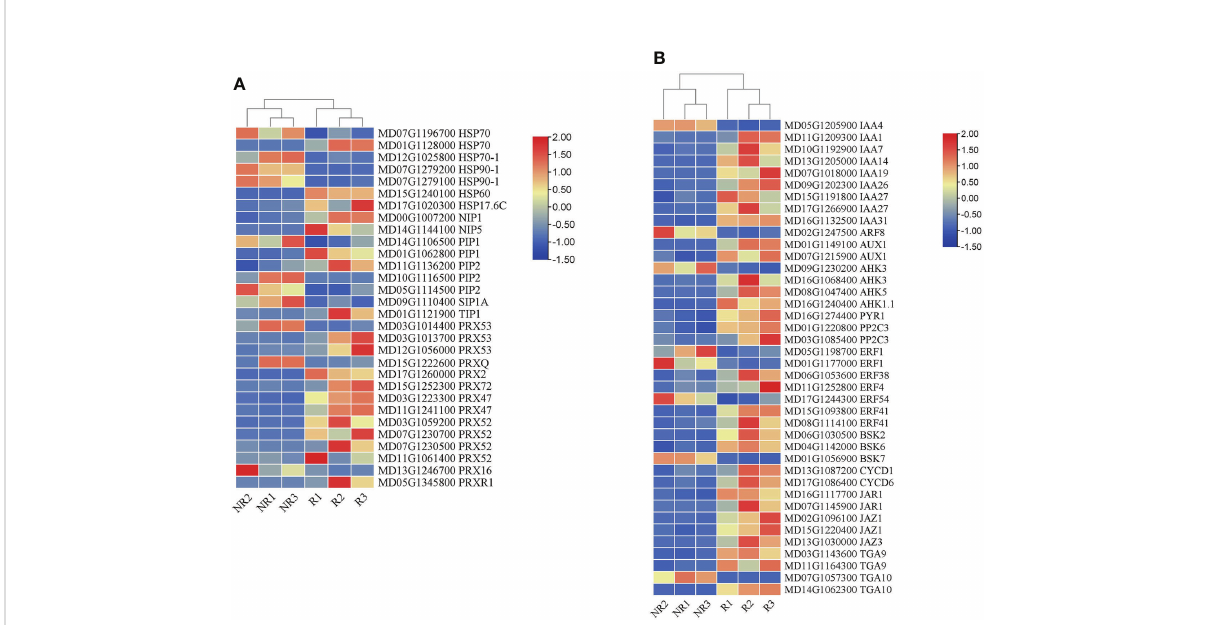
FIGURE 6 Expression heatmap of DEGs related to stress responses (A) and phytohormones (B) between the two fruit